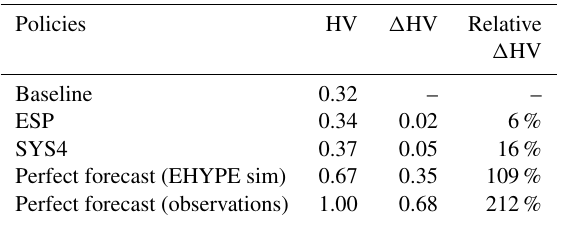
Table 2. Value of ESP, SYS4, and perfect forecasts in terms of hy- pervolume indicator